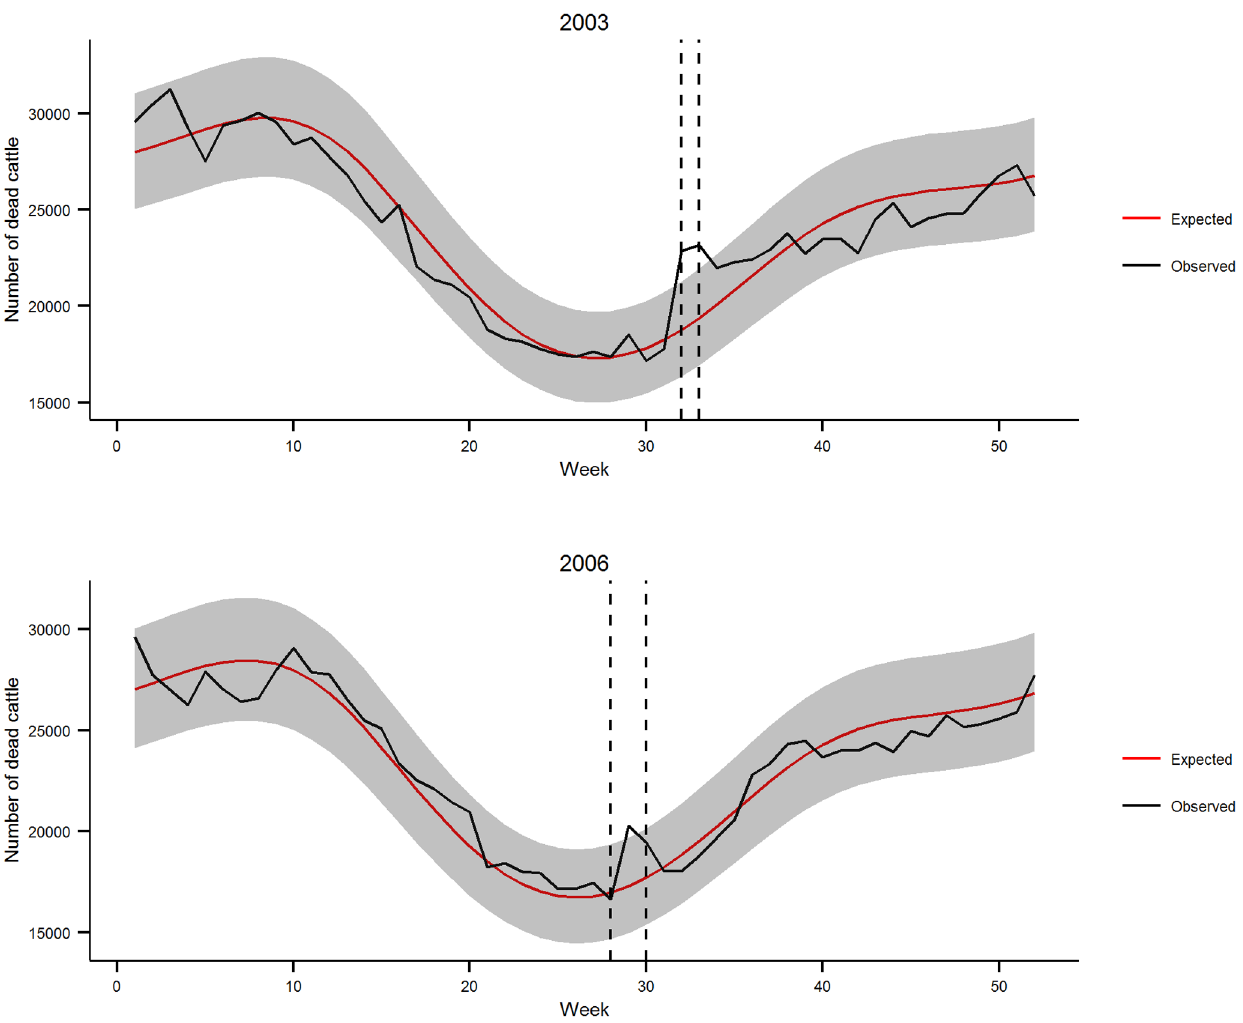
Figure 1. Overall weekly cattle mortality in France in 2003 and 2006. Dashed lines indicate the heat wave period in 2003 (weeks 32–33) and 2006 (weeks 29–30). Expected mortality is represented by the red line (with the 99% confidence interval in gray), and observed mortality by the dark line.